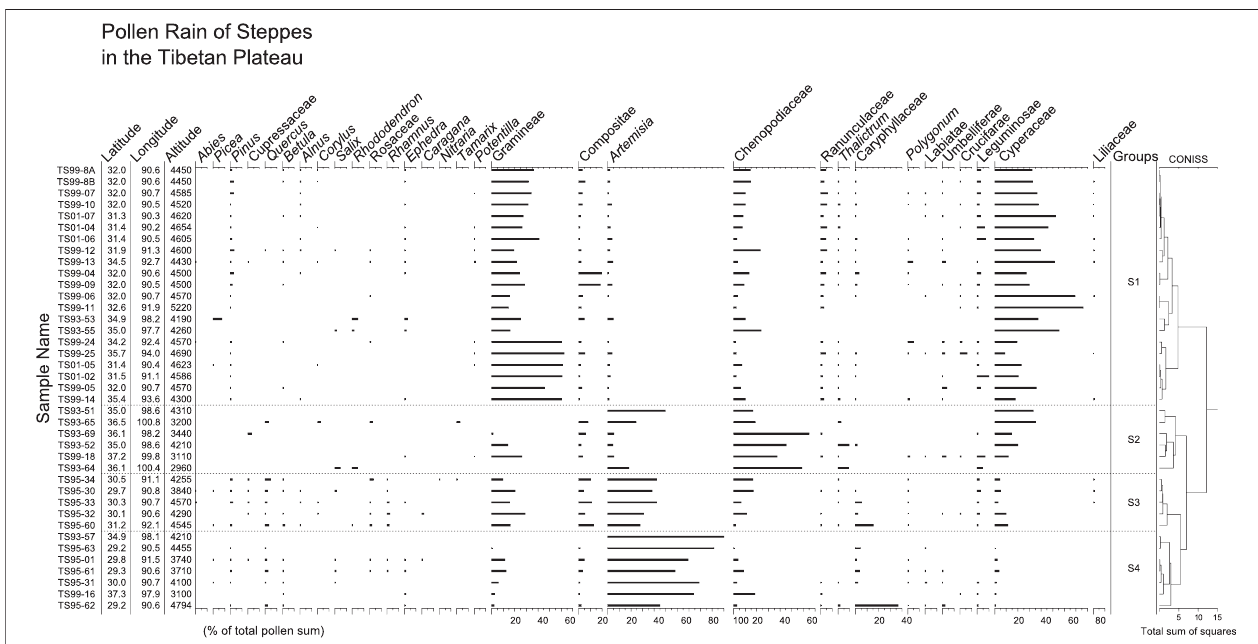
FIGURE 7 | Pollen percentage diagram for surface samples form steppes in the TP. Samples of groups S1, S2, S3, and S4 are from Stipa steppe, dry steppe, Poaceae- Artemisia steppe, and Artemisia steppe, respectively.